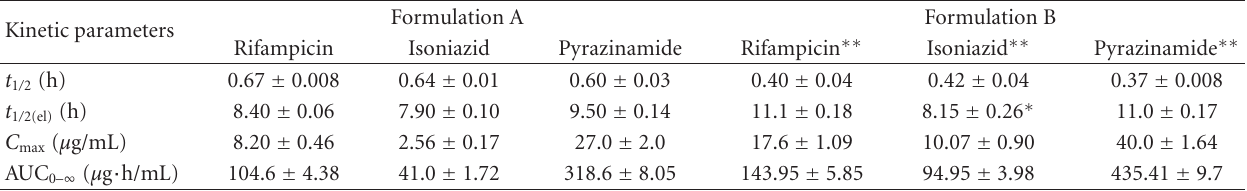
Table 7: E ff ect of piperine on pharmacokinetics of rifampicin, isoniazid, and pyrazinamide combination in human volunteers [107, 108]. Formulation Kinetic parameters